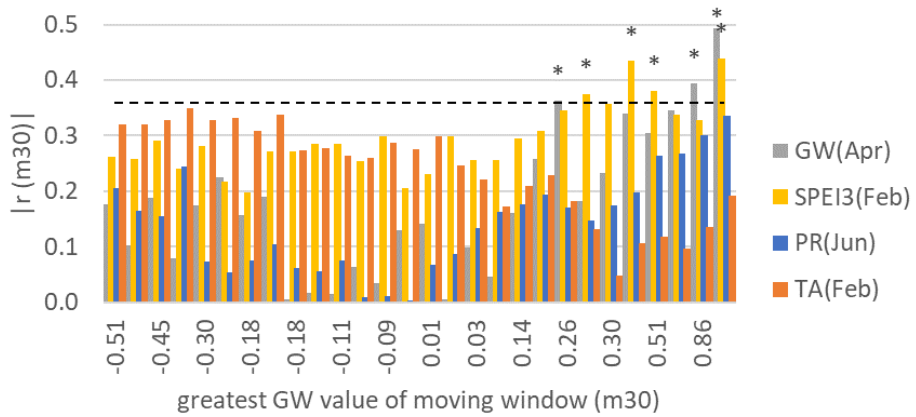
Figure 5. Correlation coefficients in absolute values between TRWI series and selected hydro-climatic variables of GW in April, SPEI3 of February, PR in June, and TA of February, based on a moving window of 30 data pairs along a sequence, with higher GW values marking drier hydrological conditions, resampling the period 1961–2017. Bars exceeding the dashed horizontal black line, marked with *, indicate significant correlations at p < 0.1 level. Note that correlation coefficients with GW(Apr) and TA(Feb) are characteristically negative, while for SPEI3(Feb) and PR(Jun), they are characteristically